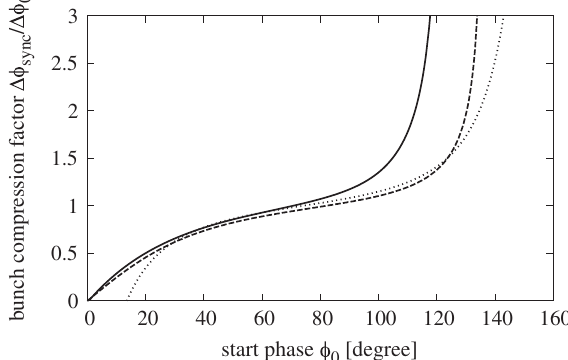
FIG. 3. Bunch compression factor versus start phase for α ¼ 1 . 8 . The solid line shows the exact, numerical solution, the dashed line follows Eq. (20), and the dotted line corresponds to Eq. (15).